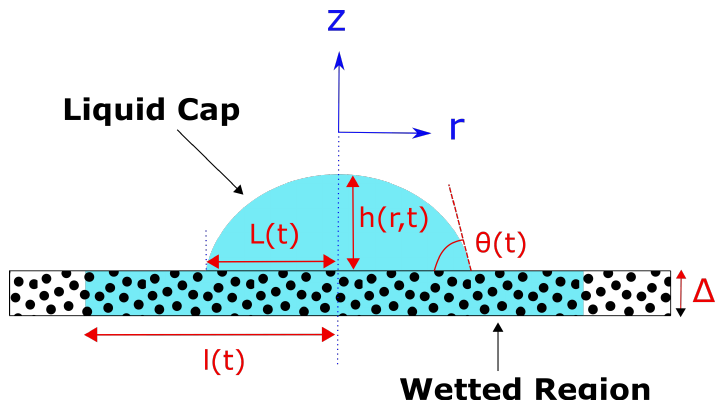
Figure 2. Schematic representation of the simultaneous droplet spreading and imbibition process.